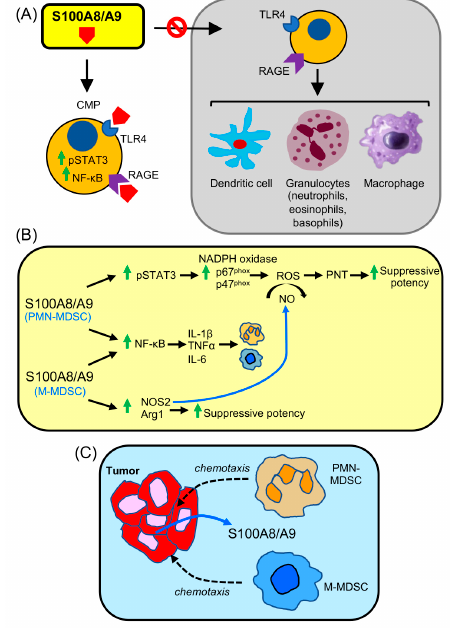
Figure 3. S100A8/A9 drives the differentiation, accumulation, and suppressive potency of MDSCs. ( A ) In normal myelopoiesis, CMPs differentiate into dendritic cells, macrophages, and granulocytes (neutrophils, eosinophils, and basophils). If S100A8/A9 is present, such as during inflammation or stress situations, then S100A8/A9 engages RAGE or TLR4 receptors on CMPs. The STAT3 and NF- κ B transcription pathways are then activated by phosphorylation and translocation to the nucleus, respectively. ( B ) In PMN-MDSCs, activation of STAT3 upregulates the NADPH oxidase subunits p67 phox and p47 phox within PMN-MDSCs resulting in the production of reactive oxygen species (ROS). ROS enables nitric oxide (NO) to react with superoxide to produce peroxynitrite (PNT), which nitrates T cell receptors, MHC molecules, and chemokines resulting in dysfunctional T cells and blocking chemokine-mediated T cell chemoattraction. NF- κ B activation results in the synthesis of IL-1 β , TNF α , and IL-6, which exacerbate inflammation and further drive the accumulation of MDSCs. NF- κ B is also activated in M-MDSCs along with upregulation of Arg1 and NOS2. Arg1 release depletes T cell L-arginine, an essential amino acid for T cell activation and function. NOS2 generates NO, which in conjunction with ROS produces PNT. ( C ) S100A8/A9 released by tumor cells chemoattracts MDSCs to the TME, where they suppress tumor-reactive T